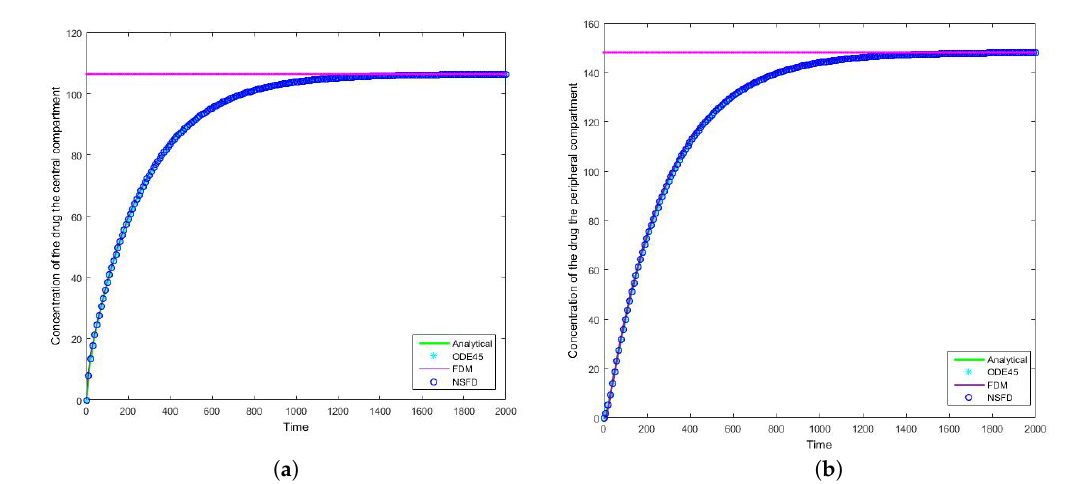
Figure 7. The concentration of the drug for Case 2 where h = 10 in the ( a ) central compartment, and ( b ) peripheral compartment. At the steady state, the rate of drug infusion ( I 0 ) is equal to the elimination rate ( k 10 ).